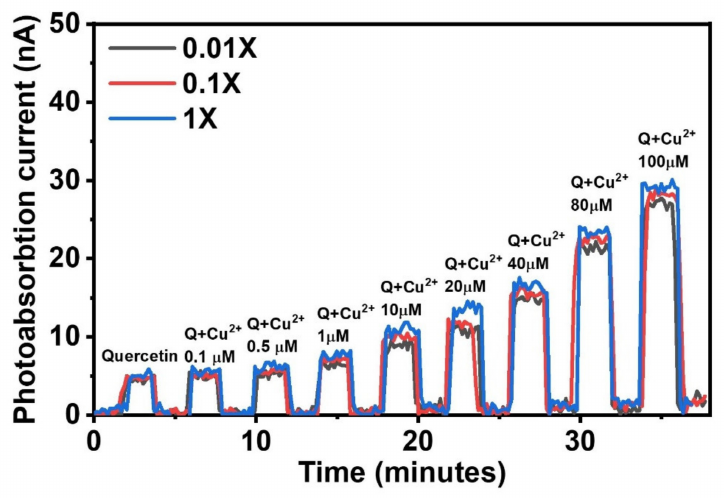
Figure 6. Absorption measurement of quercetin–Cu 2+ ion mixture for various Cu 2+ concentrations ranging from 0.1 µ M to 100 µ M in three different concentrations of PBS solution. A 100 µ M quercetin was used as a control sample.